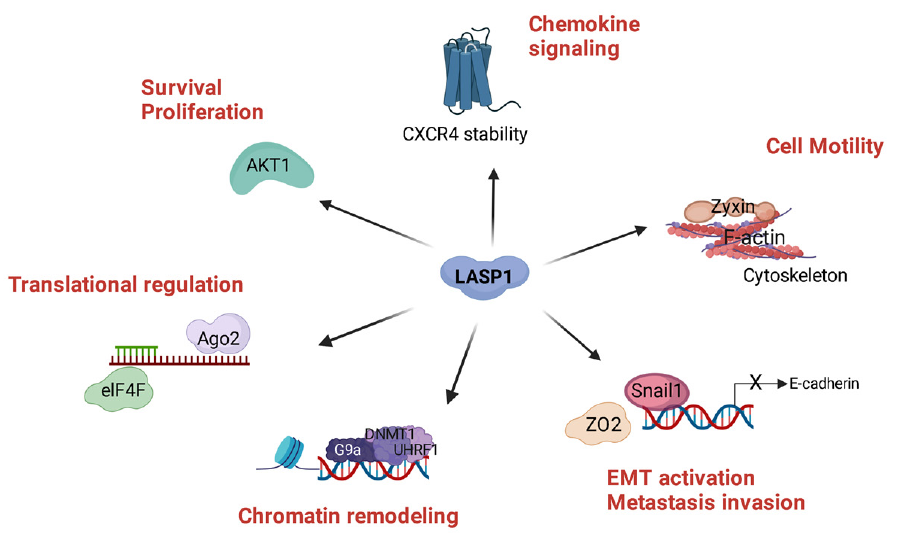
Figure 5. LASP1, a Hub for Cancer Progression. LASP1 is a multifaceted protein in cancer progression and metastasis through several direct and indirect protein interactions. LASP1 binds to F-actin and is localized to actin rich protrusive structures such as invadopodia and lamellipodia, necessary for invasion and metastasis. Cancer cell viability and proliferation are promoted through activation of the PI3K/AKT signaling pathway, presumably through the LASP1 scaffolding function at the cell membrane. LASP1 plays a role in chemokine signaling by modeling CXCR4 stability, a receptor also overexpressed in several cancer entities. Nuclear LASP1 presence promotes metastasis by stabilizing Snail1 and enhancing epithelial-mesenchymal transition (EMT) and by remodeling chromatin to alter the transcriptome. Expression of mRNA is regulated by the interaction of LASP1 with Ago2, a protein of the RNA-induced silencing complex (RISC) and with eukaryotic initiation factor 4F complex (eIF4F) which induces translation of mRNA into oncoproteins. Created with BioRender software: https://biorender.com, accessed on 18 November